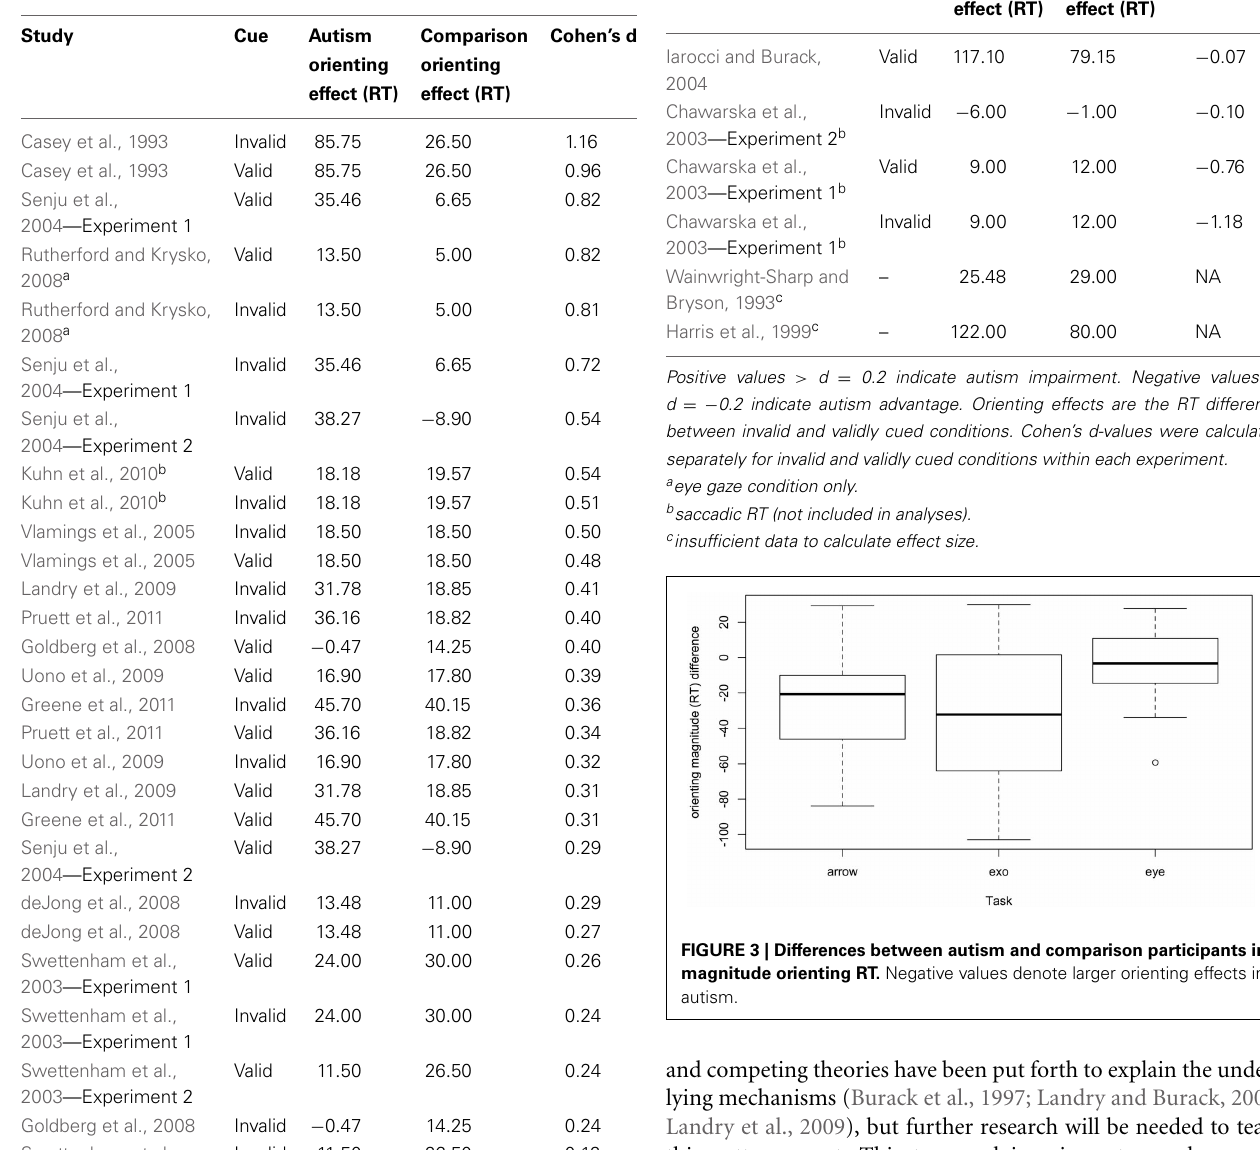
Table 4 | Magnitude of the orienting effects (invalid—valid RT) and overall Cohen’s d effect sizes for each experiment, presented in descending order from largest autism impairment to largest autism advantage.